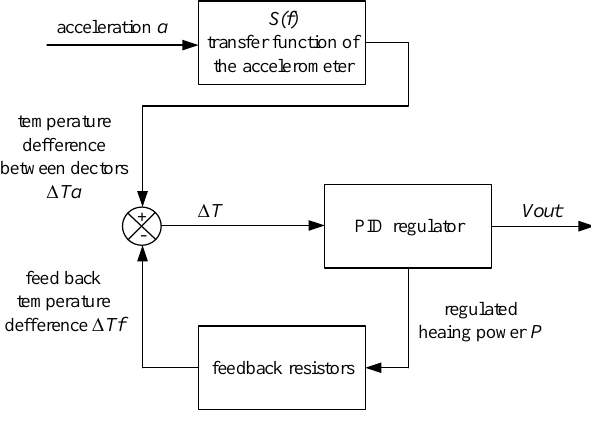
Figure 13. Block-diagram overview of the closed-loop configuration.